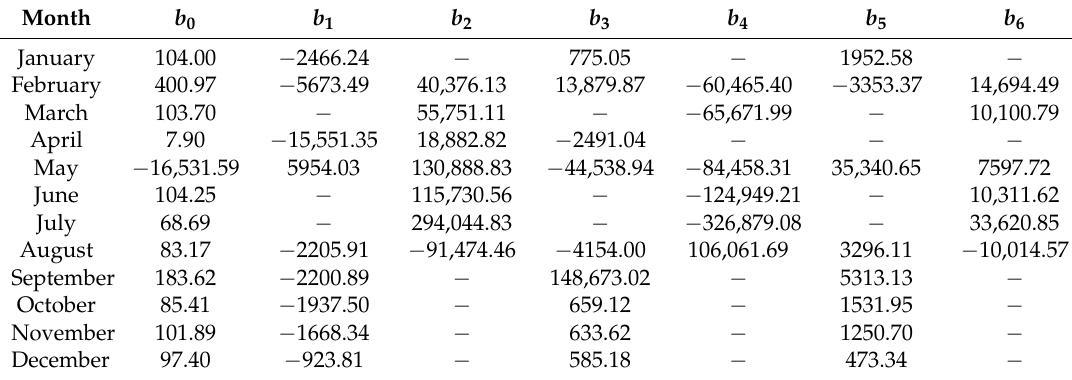
Table 7. The monthly regression coefficients for the MLRA